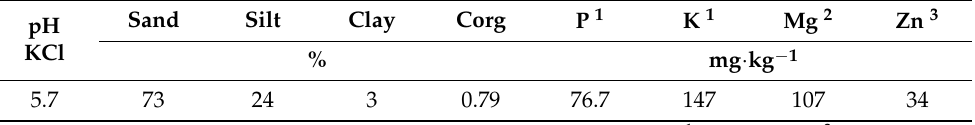
Table 1. Properties of soils used in the